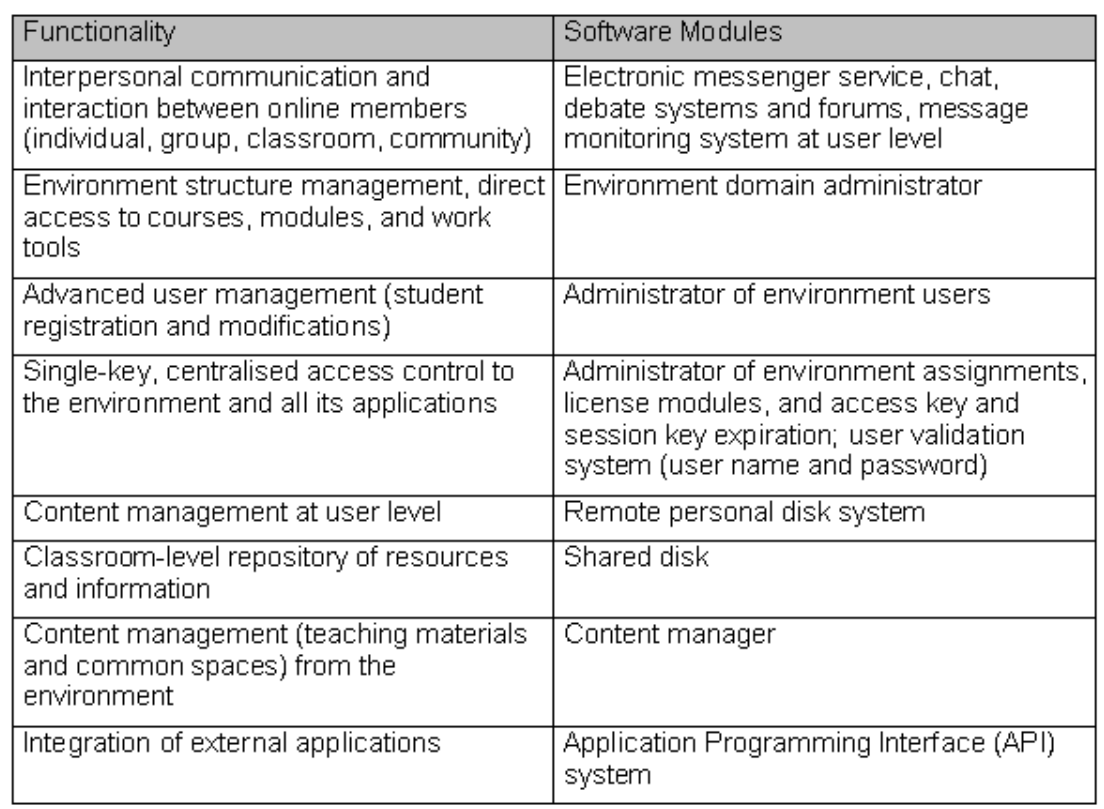
Table 1. Functionality and Features of the UOC Campus Virtual